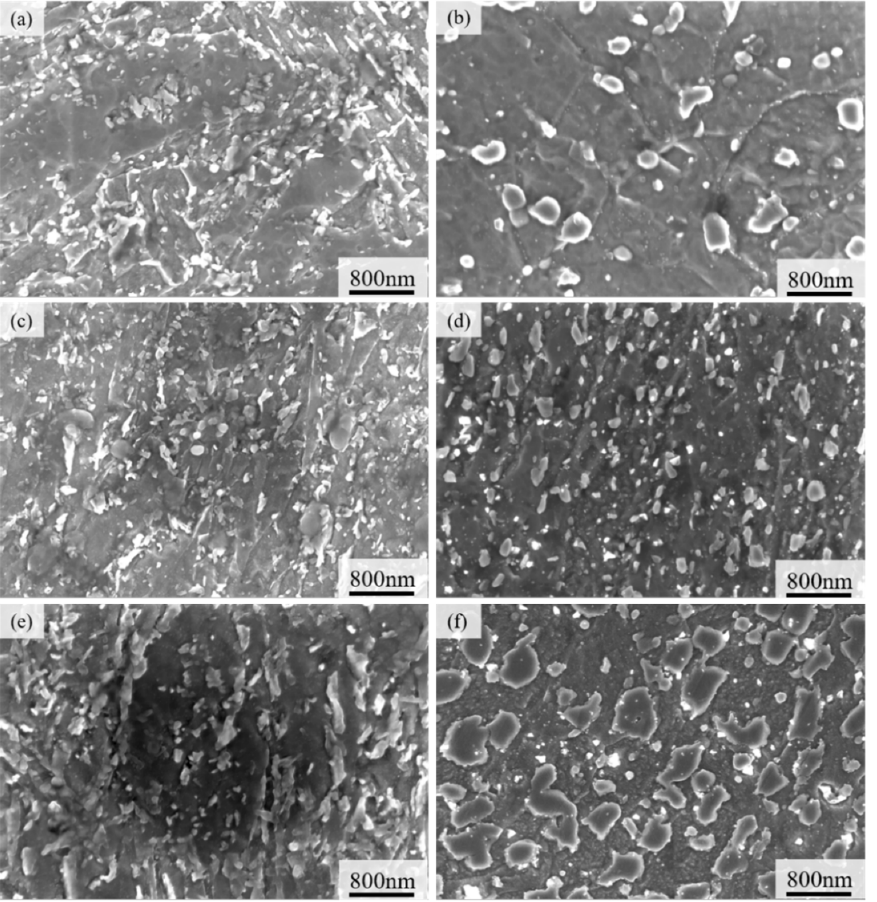
Figure 6. Precipitation phase and precipitates morphology before and after thermal fatigue cycle: ( a ) ZG1-pre; ( b ) ZG2-pre; ( c ) ZG3-pre; ( d ) ZG1-after; ( e ) ZG2-after; ( f ) ZG3-after. The size of the precipitates varied significantly, especially in ZG2, where they were uniformly dispersed and rather small and regular in size. The quantity and area of the three precipitates were computed, as shown in Figure 7. The statistical finding showed that the number of precipitates was 145, 391, and 319 for ZG1, ZG2, and ZG3, respectively, within an area between 0 and 1 × 10 4 nm 2 . It has been well documented that the precipi- tates in the range of 0–100 nm are called nano-precipitates, and substantially contribute to enhancing material performance [24]. In the process of phase coarsening, the fatigue strength of the alloy decreased gradually, the fatigue crack deflection became more seri- ous, the propagation became more unstable, and the crack growth rate increased.